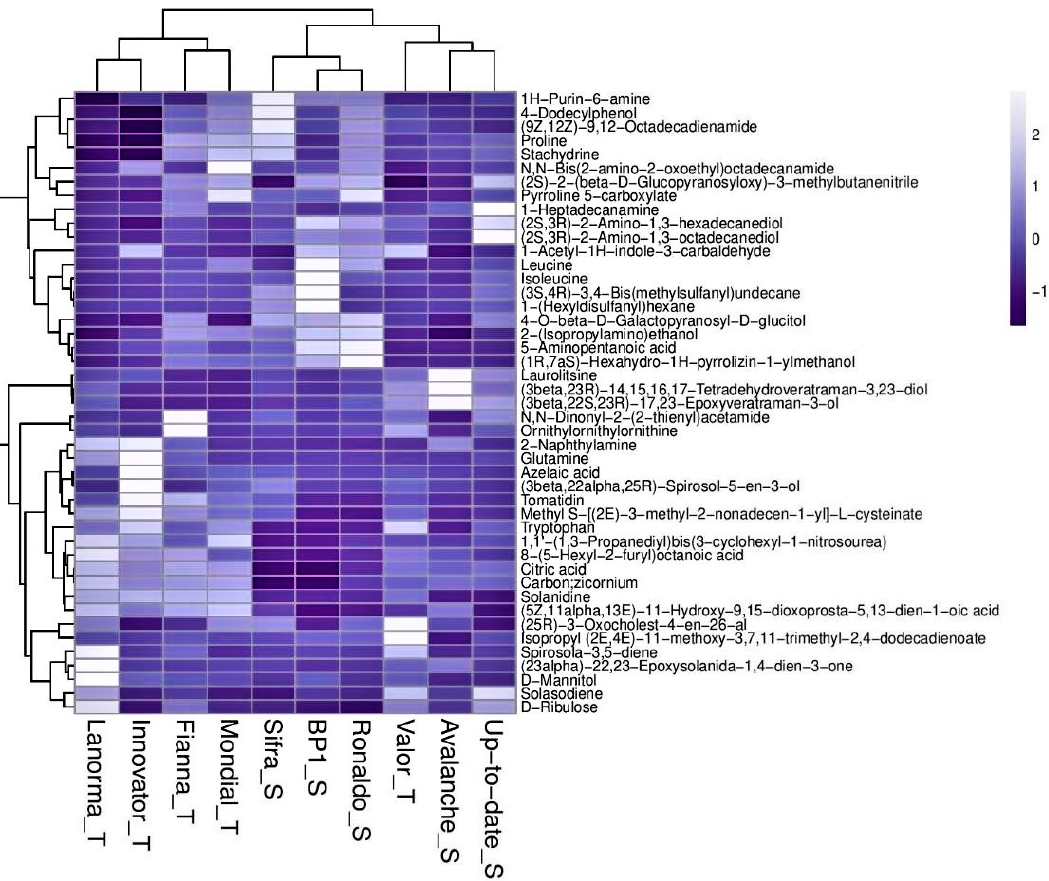
Figure 5. Two-way hierarchical clustering analysis visualized using a dendrogram combined with a heat map. The heat map represents the intensities of the metabolites in the roots of 10 cultivars (T = tolerant cultivar and S = susceptible